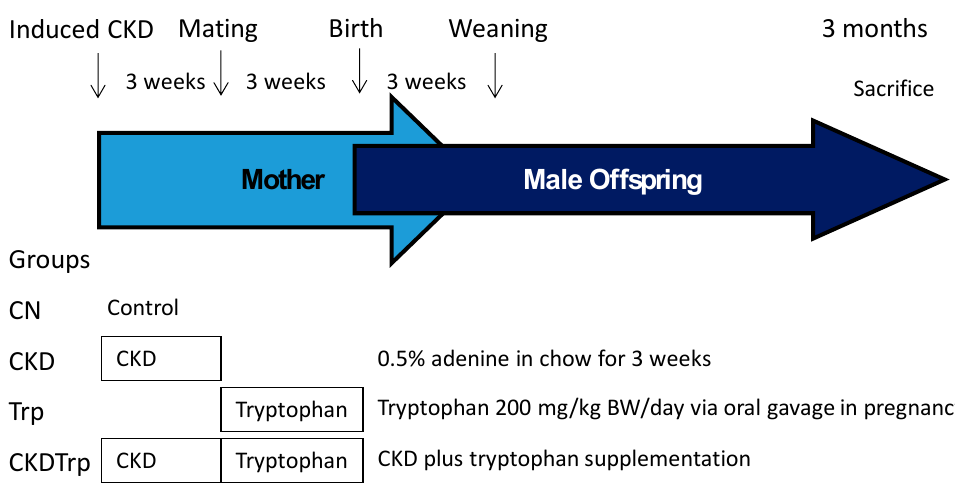
Figure 7. Schematic illustration of study design to establish a maternal adenine-induced chronic kidney disease (CKD) rat model to evaluate male o ff spring outcome at 12 weeks of age. Table 3. Quantitative real-time polymerase chain reaction primers